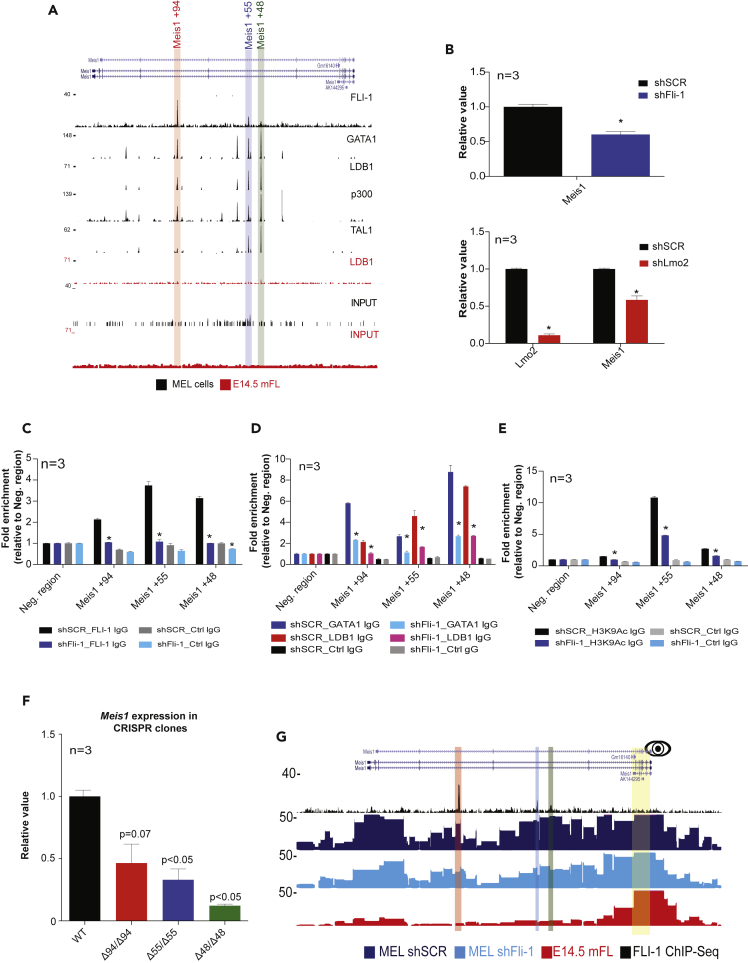
Fli-1 enables the recruitment of the LDB1 complex to 3 Meis1 enhancers and promotes chromatin looping between these enhancers and the Meis1 promoter in MEL cells(A) ChIP-Seq profiles of Fli-1, TAL1, GATA1, and LDB1 in MEL cells (black) and in fetal liver cells (red) showing three binding regions located 94, 55, and 48 kb downstream of the Meis1 promoter.(B) Top panel: Meis1 mRNA level from non-induced (dark color bars) and induced (light color bars) control (shSCR, black bars) or shFli-1 (blue bars) MEL cells. Bottom panel: Lmo2 and Meis1 mRNA level from control (shSCR, black bar) or shLmo2 transduced (red bar) MEL cells. The values are normalized to the value obtained for the Actb reference gene and those of control cells. Bars represent the geometric mean of three independent experiments. The error bars represent the standard error of the mean. ∗: p < 0.05 for the comparison between shSCR condition and the others (paired t test).(C–E) Fli-1 (C), GATA1, LDB1 (D), and H3K9Ac (E) ChIP-qPCR experiments from control (shSCR, black) or shFli-1 (blue) MEL cells and primers amplifying the control Amylase region (Amy), the Meis1 +94, +55, and +48 regions. The bars represent the geometric mean of three replicates. The error bars represent the standard error of the mean. ∗: p < 0.05 for the comparison between shSCR condition and the others (paired t test).(F) Meis1 mRNA levels from WT (black bar), Δ94/Δ94 (red bar), Δ55/Δ55 (blue bar), and Δ48/Δ48 (green bar) MEL cells. The values are normalized as in the panel c. The p values indicated above the bars have been obtained with a paired t test comparing WT MEL cells versus the Meis1 enhancer deleted CRISPR clones from three independent experiments.(G) Fli-1 ChIP-Seq (black) and T2C profile of control (dark blue) or shFli-1 (light blue) MEL cells and E14.5 fetal liver cells (red) in the Meis1 locus. The Meis1 promoter is used as a viewpoint indicated by the eye symbol.See also Figures S2 and S3.